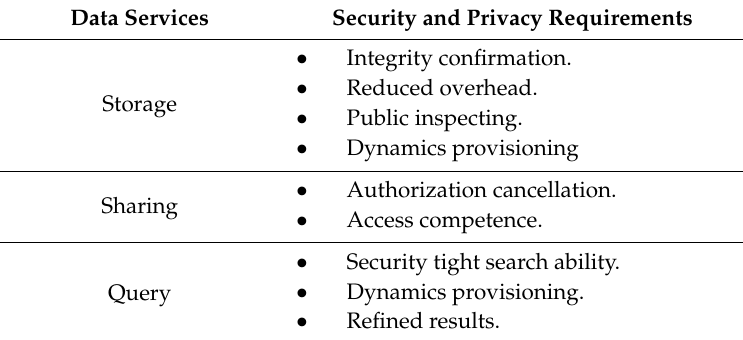
Table 6. Security and privacy requirements for the data